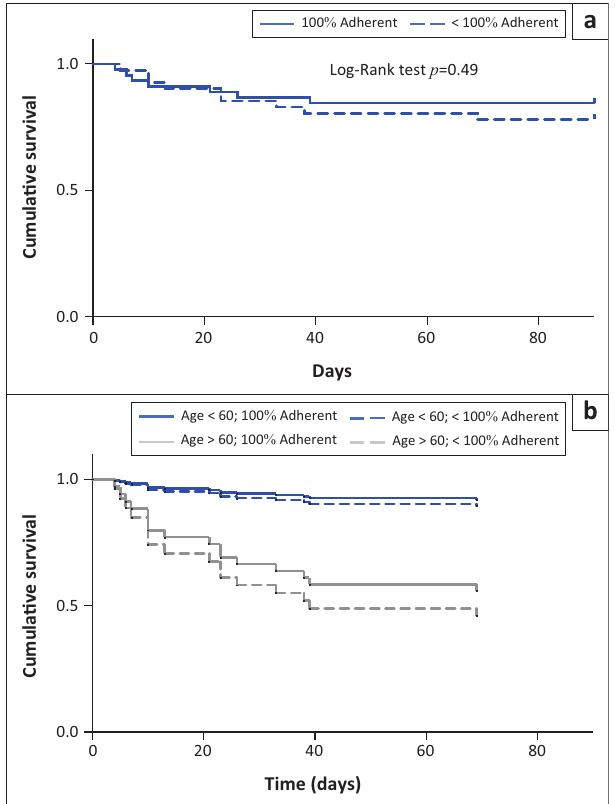
FIGURE 1: Survival curves for patients with Staphylococcus aureus bacteraemia. (a) Kaplan–Meier curve for patients with full versus < 100 % adherence. (b) The Cox proportional hazards regression stratified by age and adherence. Hazard ratio (HR) (95 % confidence interval [CI]) for age > 60 versus not: 7.0 (2.6–20.5); HR (95 % CI) for 100 % adherent versus not 0.8